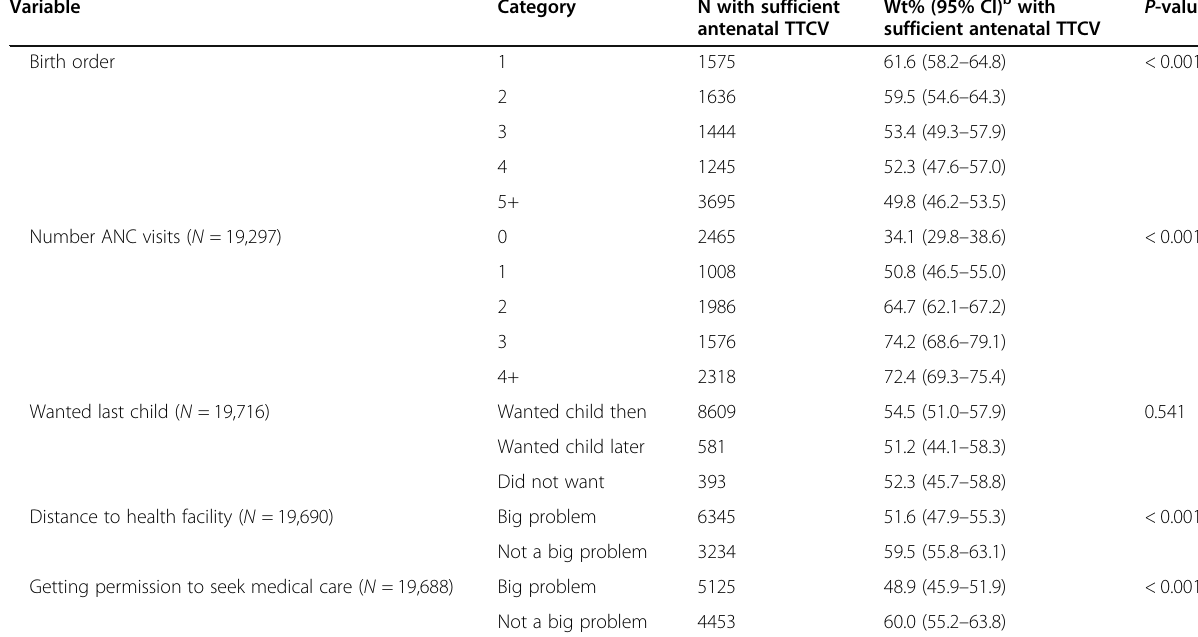
Table 2 Associations between various independent variables and a woman having sufficient TTCV in her most recent pregnancy resulting in a live birth within the past 5 years a (Continued)